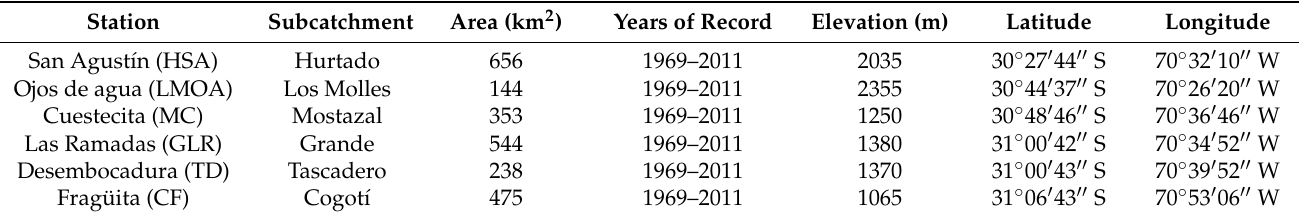
Table 1. Streamflow gauges in the Limar í